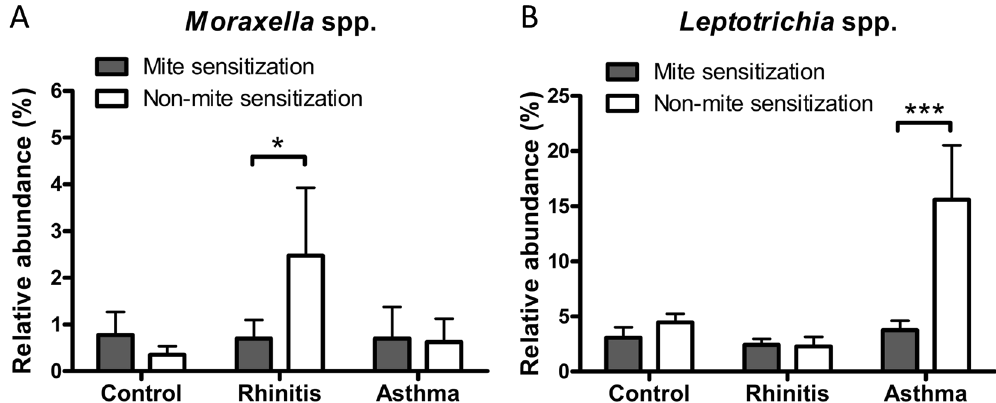
Figure 3. Genera Moraxella and Leptotrichia involving in the interaction between mite sensitization and allergic airway diseases. Moraxella spp. ( A ) and Leptotrichia spp. ( B ) showing significantly increased abundance in rhinitis and asthma without mite sensitization,